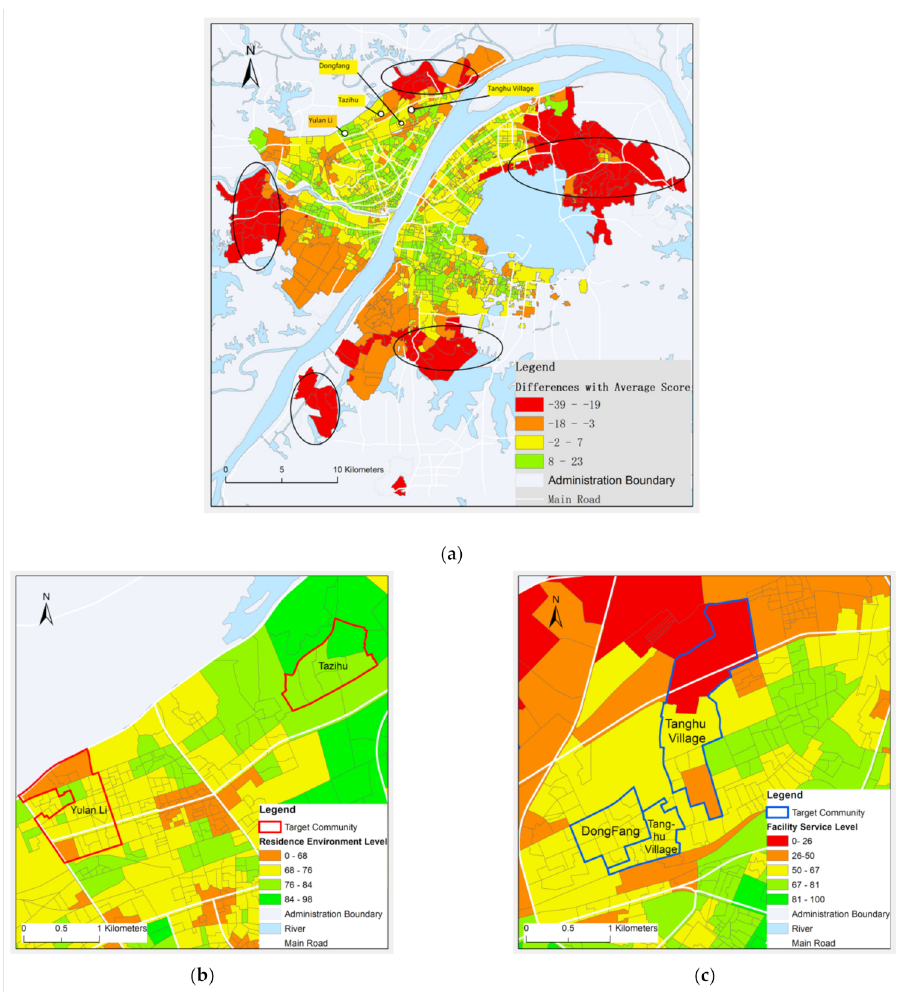
Figure 10. Spatial heterogeneity of community livability:( a ) Differences with the average community livability; ( b ) Difference of residence environment by grids; ( c ) Difference of facility service level by grids. ( a ) shows the distribution of differences between livable score and average score for each community. ( b , c ) shows the difference of residence environment, facility service level in grids